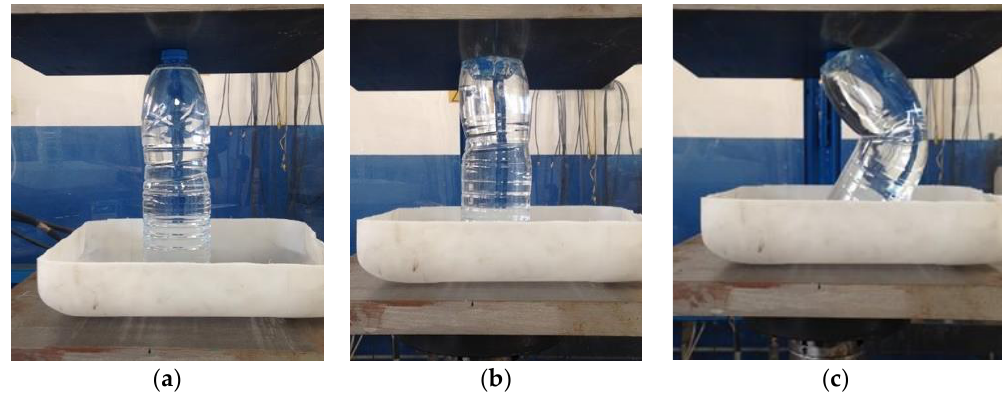
1 Figure 5. Predominance of buckling on single-bottle compression tests: initial part of the test with a proportional response ( a ), as soon as the bottleneck is completely dented ( b ), and near to the 3% strain region when buckling takes place ( c ).